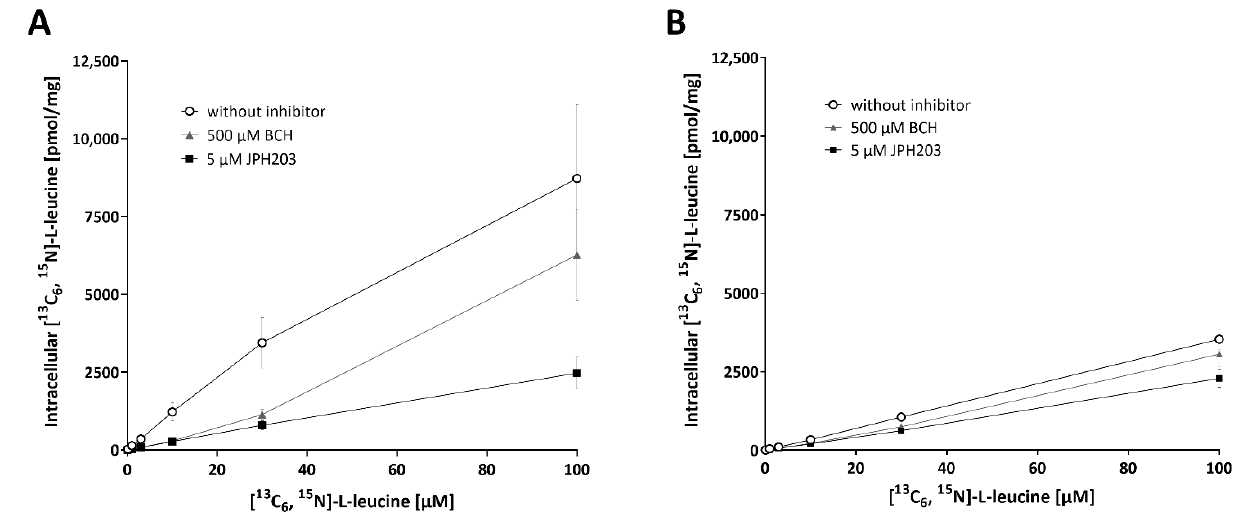
Figure 4. Concentration-dependent uptake of [ 13 C 6 , 15 N]-L-leucine without inhibitor, with 5 µM JPH203 and 500 µM BCH in ( A ) hCMEC/D3 and ( B ) NKIM-6. Concentration of intracellular [ 13 C 6 , 15 N]-L-leucine was normalized to protein content. Data are depicted as mean ± SD from three independent experiments with at least three replicates.